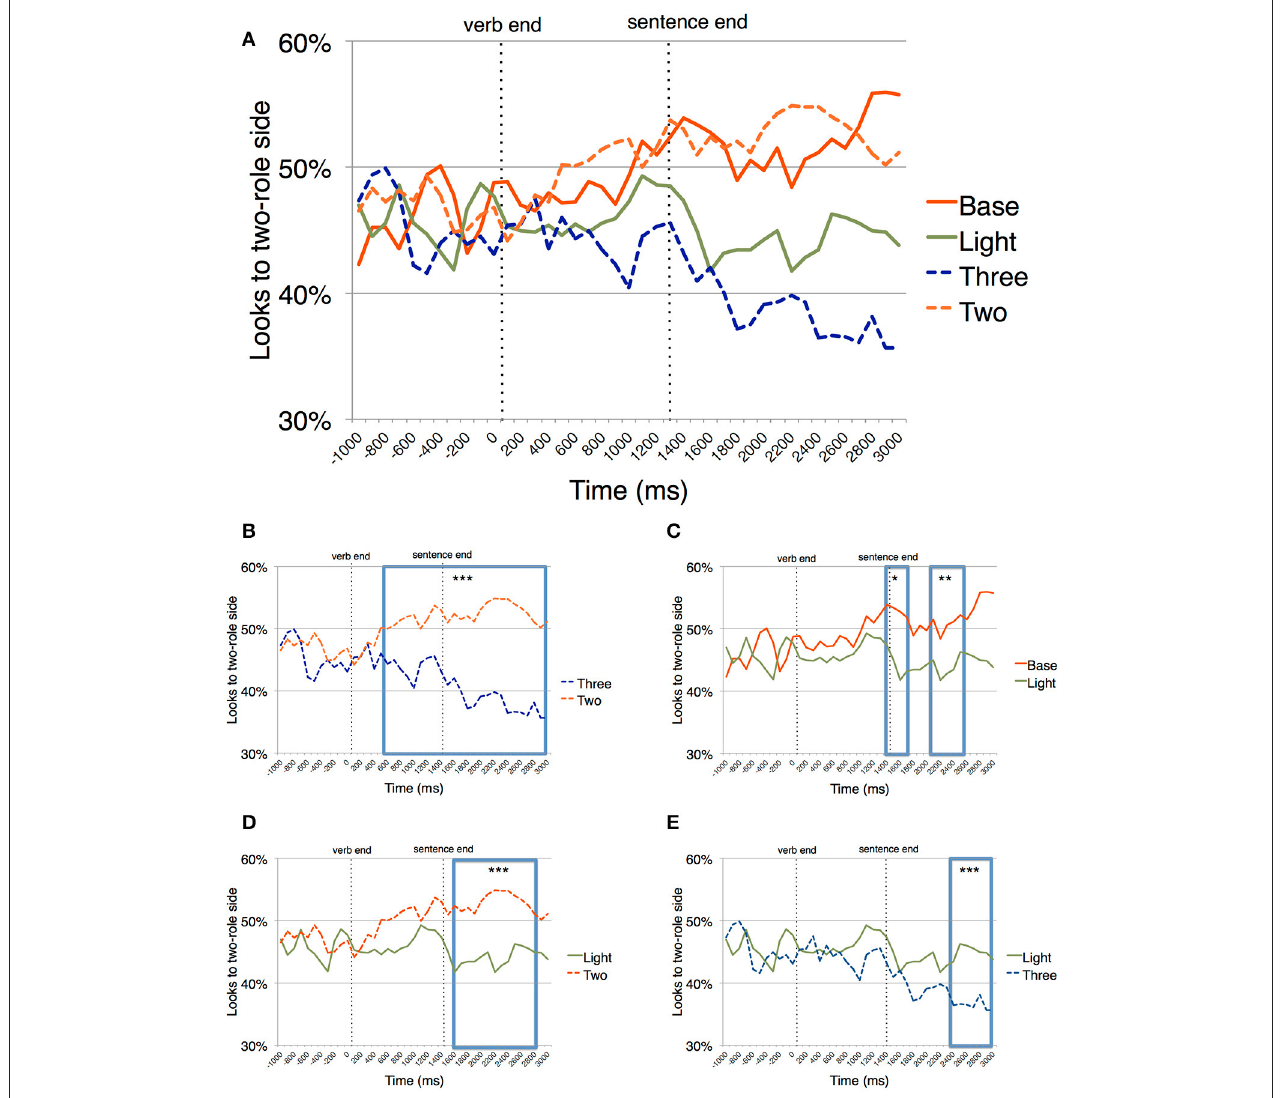
FIGURE 3 | Percentage of looks to the two-role side over time. (A) While looks during the comprehension of two- and three-role sentences diverge early on, looks during the comprehension of light verb constructions do not pattern with either one. (B) Pairwise comparison between looks during comprehension of two- and three-role sentences. (C) Pairwise comparison between looks during comprehension of base and light sentences. (D) Pairwise comparison between looks during comprehension of two-role and light sentences. (E) Pairwise comparison between looks during comprehension of three-role and light sentences (Significance